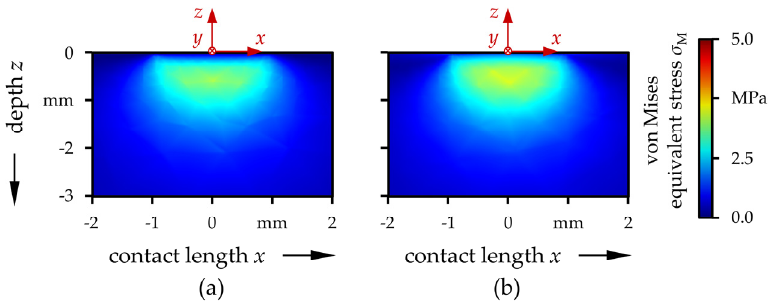
Figure 5. Calculated von Mises equivalent stress distribution in the y = 0 cross-section plane of the UHMWPE disk ( a ) and the CoCr pin ( b ).